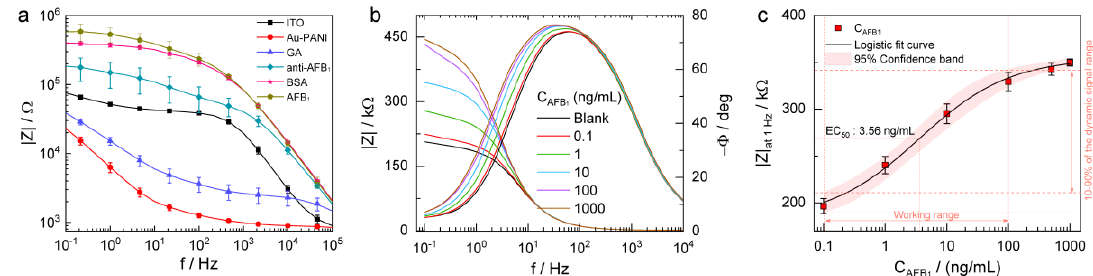
Figure 5. ( a ) Bode plots obtained after various steps of the surface modification process for ( ) ITO; ( ) Au-PANI; ( ) glutaraldehyde (GA); ( ) anti-AFB 1 ; ( ) for BSA and ( ) for AFB 1 (100 ng/mL) for developing the aflatoxin detection sensor. Data points indicate the mean ± SD of four replicated impedance measurements; ( b ) Impedance magnitude measured from different concentration of aflatoxin B 1 (C AFB1 ) in phosphate buffer saline (PBS) measured from blank, 0.1 to 1000 ng/mL over the frequency range of 1 to 10 6 Hz; ( c ) Calibration curve with 95% confidence bands for AFB 1 sensor obtained at |Z| at 1 Hz for various C AFB1 . Data points indicate the mean ± SD of four replicated impedance measurements, and the fit curve represents the logistic four-parameter regression.